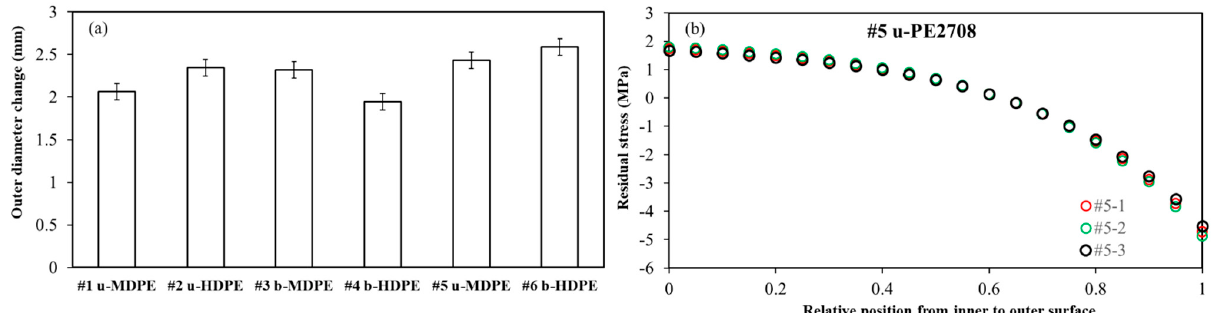
Figure 7. ( a ) Summary of the outer diameter changes after the cutting process and ( b ) the PE #5 pipe as an example of the reproducibility of the results on the three duplicates.